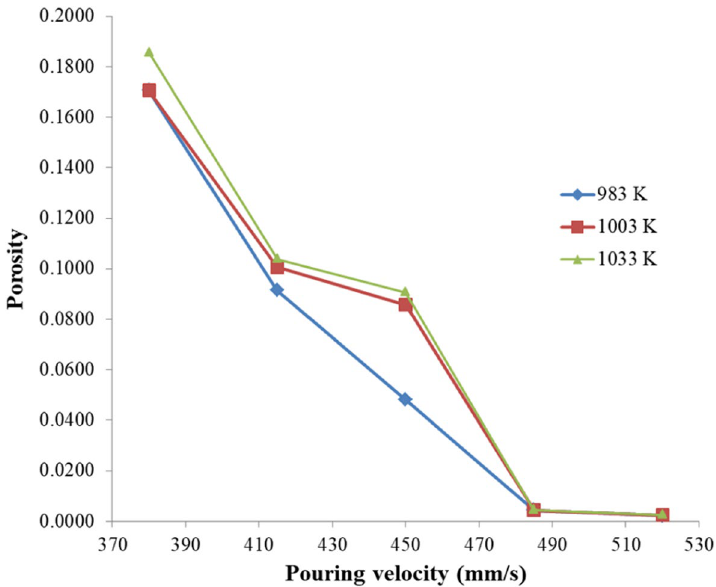
Fig. 9 Variation of porosity with pouring velocity at different pouring